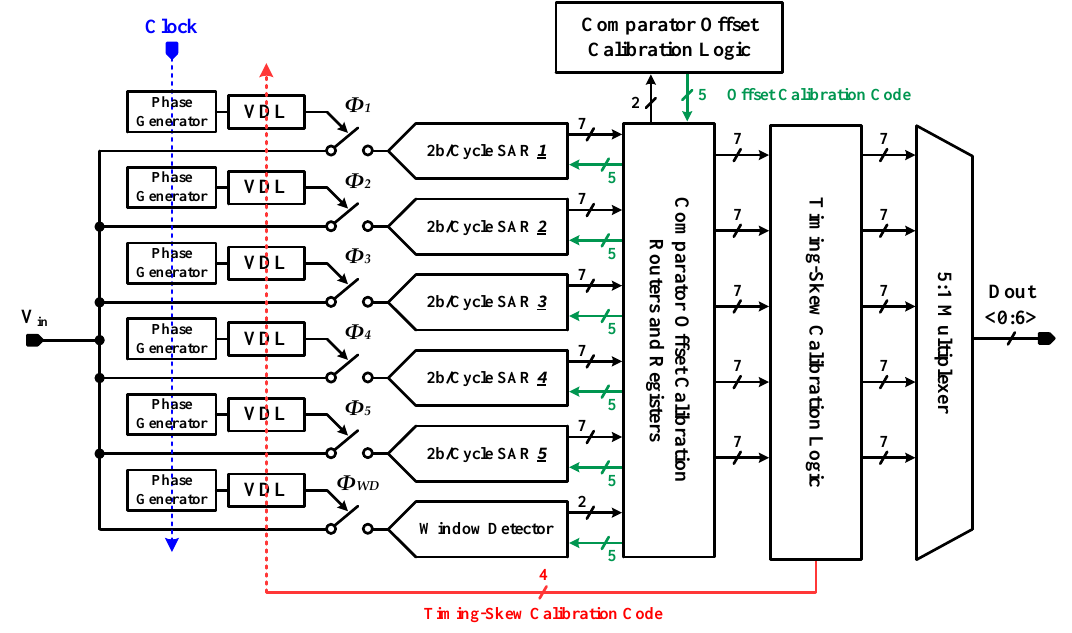
Figure 6. Block diagram of the proposed time-interleaved SAR ADC.